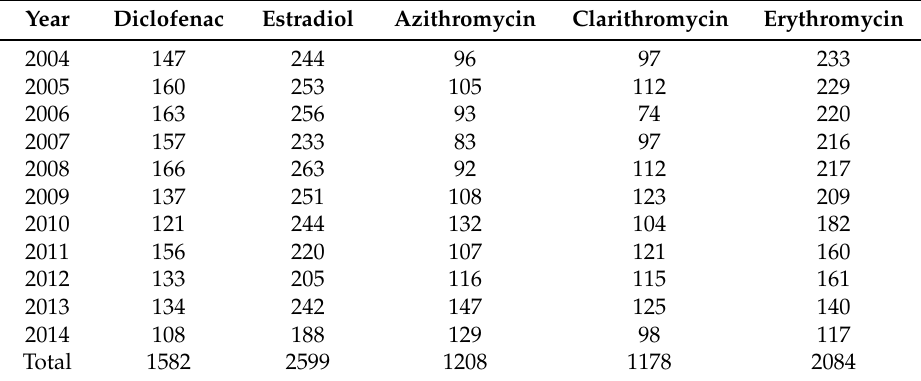
Table 6. Scopus Number of Documents with UK Affiliation with the terms Diclofenac, Estradiol, Azithromycin, Clarithromycin, and Erythromycin from 2004 to